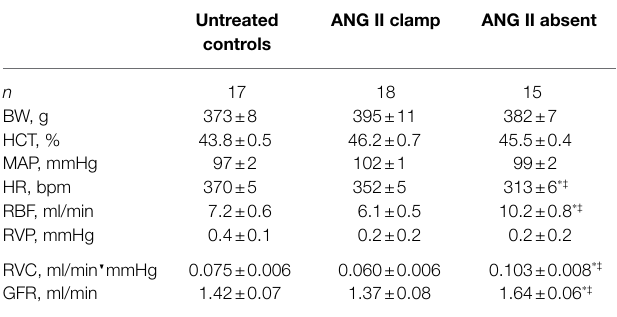
TABLE 1 | Baseline information in untreated control, ANG II Clamp, and ANG II Absent rats. Untreated